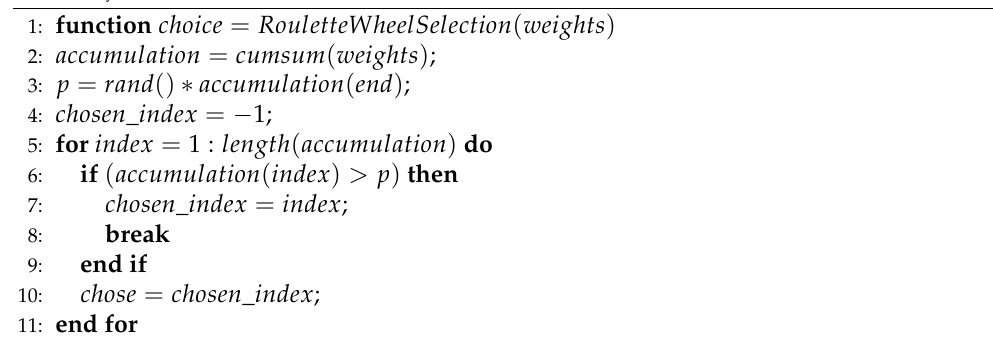
Algorithm 1 Proposed pseudocode of the roulette wheel to select universe k to transport element j to universe i